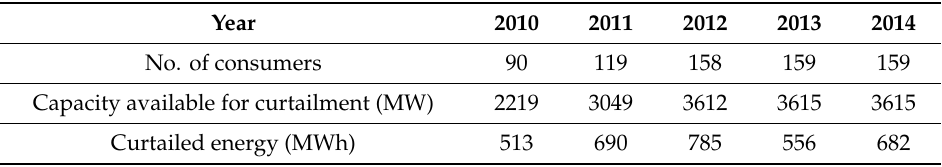
Table 1. Consumers and curtailed power before market opening [23].